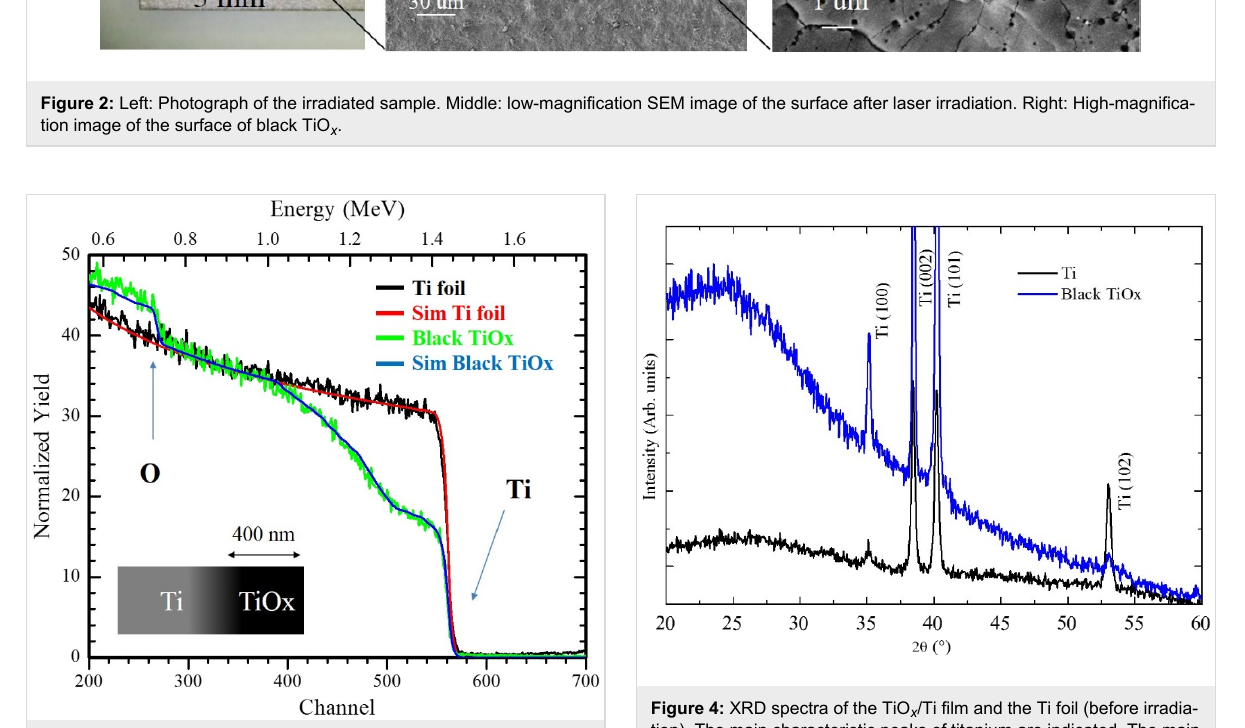
Figure 3: RBS spectra of the TiO x film and the Ti target. Arrows indi- cate signals coming from titanium and oxygen, respectively. Simula- tions of the spectra are also reported. Left lower side: a schematic representation of the irradiated sample is reported.